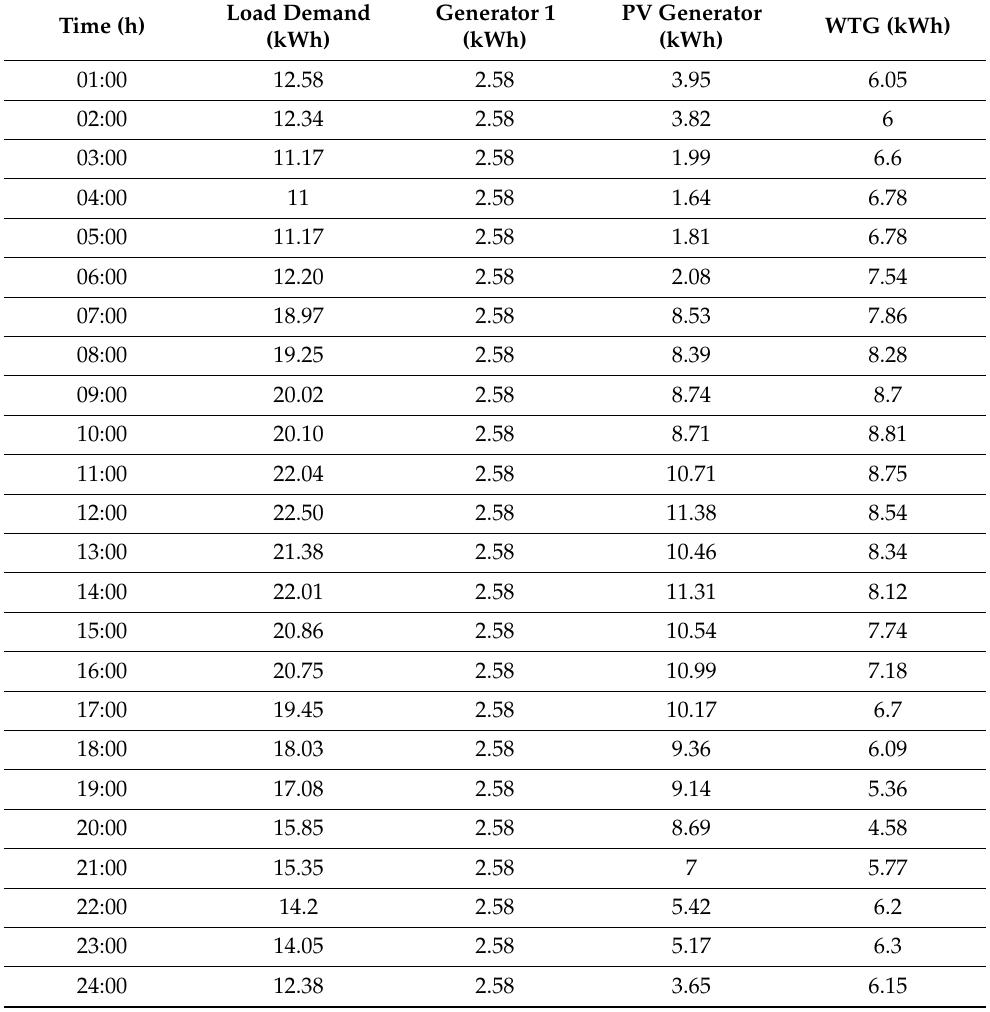
Table 7. Optimal power output for Case 4.